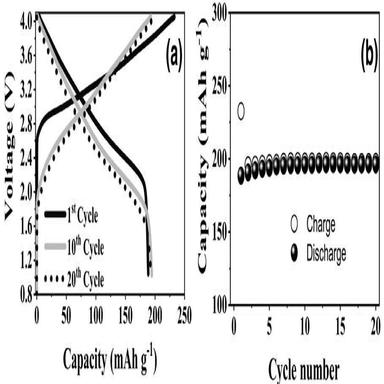
Voltage signature (a) and cycling behavior (b) of the Co3O4/LP30+2% VC/NCA lithium ion cell.